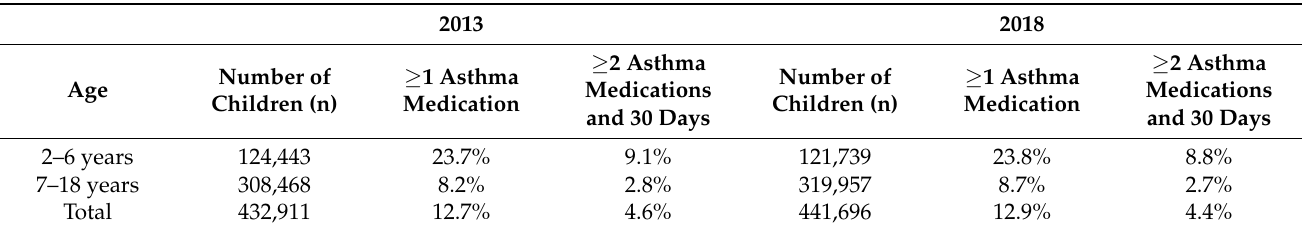
Table 1. Overview of the use of asthma drugs in 2013 and 2018 for children affiliated to the Indepen- dent Health Insurance Funds.